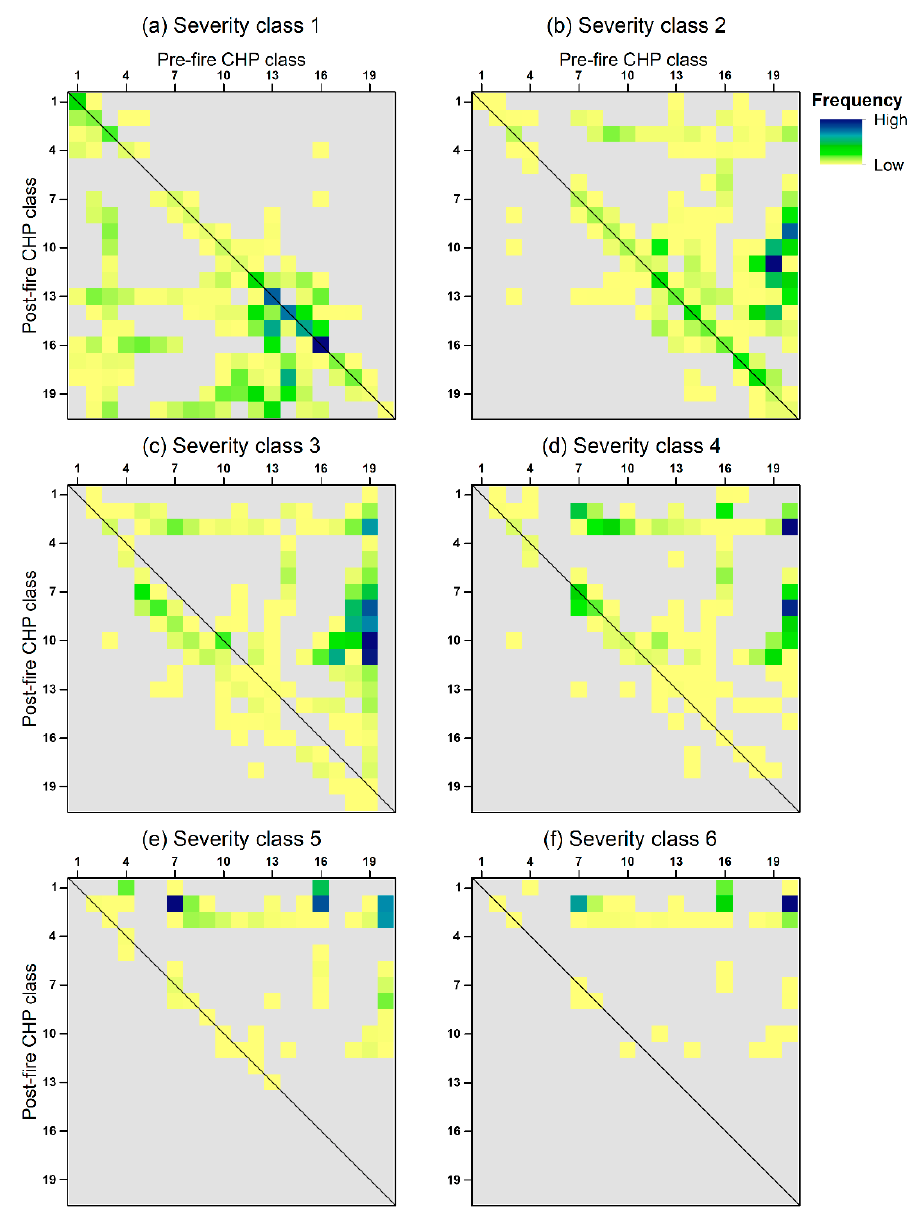
Figure 6. Transition matrices of CHP classes pre-fire to post-fire. A gray tone indicates classes with a frequency of occurrence of 0%. Locations down the diagonal indicate areas that were unchanged after the fire. Note that each image was individually contrast-enhanced in order to show the patterns within each matrix, and thus the colors are not directly comparable between the matrices.